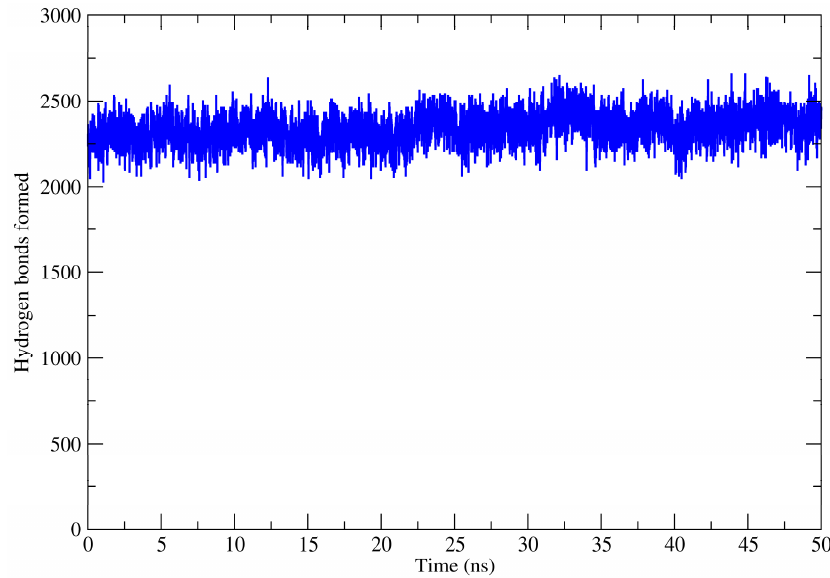
Figure 5. Hydrogen bonds formed throughout the MD simulations.